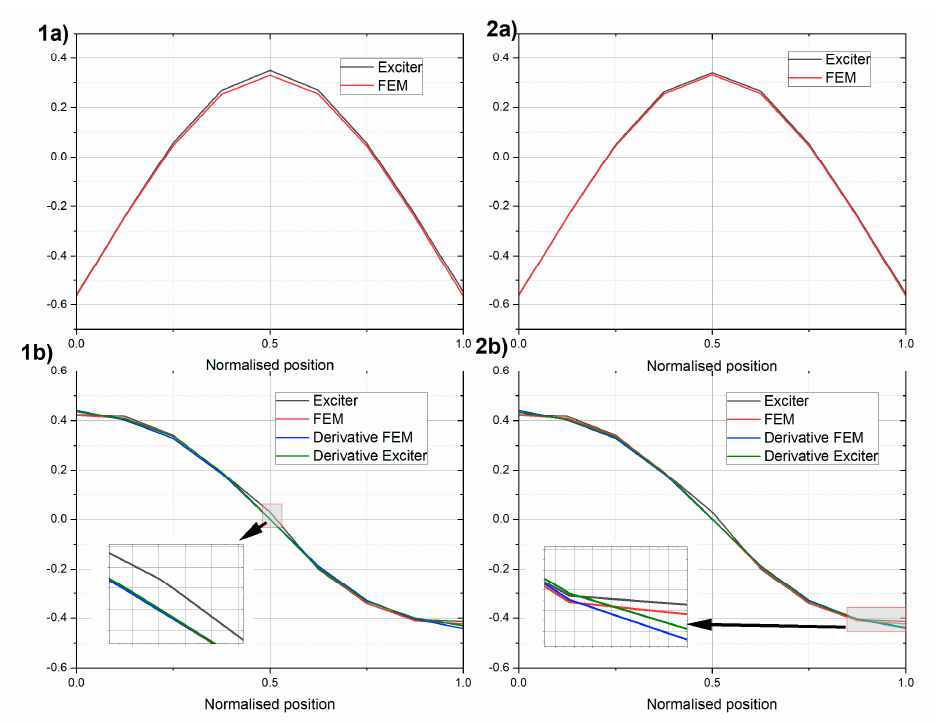
Figure 12. Amplitudes of ( a ) translational acceleration and ( b ) rotation rate of (1) beam UHPC1_L and (2) beam UHPC2_L during the inertial vibration exciter tests. Results for the intact beams. During the tests with the inertial vibration exciter, the feasibility for measuring the average strain rates and the strains using two rotation rates sensors according to the procedure presented in Section 2.4 was analyzed. The presented results are for the UHPC2_L beam in a free–free condition. The sensors and inertial exciter were set according to the configuration II scheme shown in Figure 5. The average strain rates and strains were measured for the area between axis three and axis four using the Gladiator sensors. The exciter worked with 27.26 Hz. First, the rotation rates in the selected axes were measured (Figure 13a,b), which allowed for calculating the rotation rate di ff erence between the two sensors, . . . . ε ∆ ϑ = ϑ ϑ − max , was calculated using Equation (9), with a beam 3 4 (Figure 13c). Next, the strain rate, height of h = 0.20 m, and a distance of ∆ x = 0.75 m between the sensors (Figure 13d). The strain rates were integrated according to Equation (10) (Figure 13e). Such operation resulted in the strains randomly drifting from a zero value, because of, e.g., sensor noise. In this case, the measurements could be corrected by using, e.g., a high-pass filter. Here, we restricted the analysis to a short time window and used a linear detrend function of ε corrected ( t = 20–21 s ) = detrend ε ( t = 20–21 s ) (Figure 13f). As such, the procedure allows for control of the average strains during the vibration